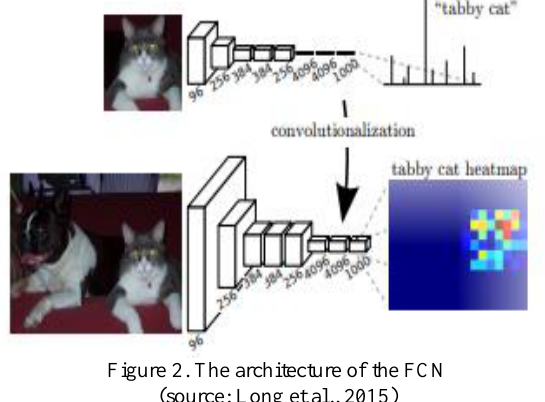
Figure 2. The architecture of the FCN (source: Long et al.,